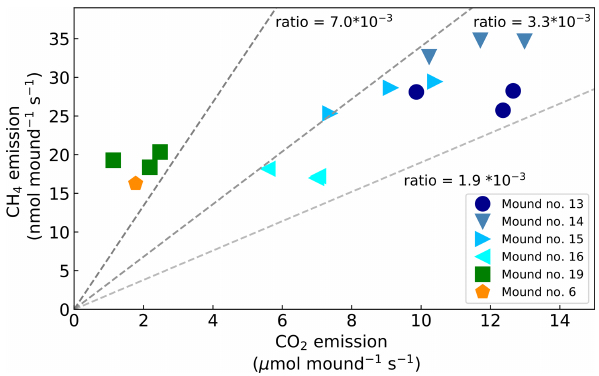
Figure 3. Mound CO 2 emissions (µmolmound − 1 s − 1 ) vs. mound CH 4 emissions (nmolmound − 1 s − 1 ). Dotted lines indicate the dif- ferent dCH 4 / dCO 2 emission